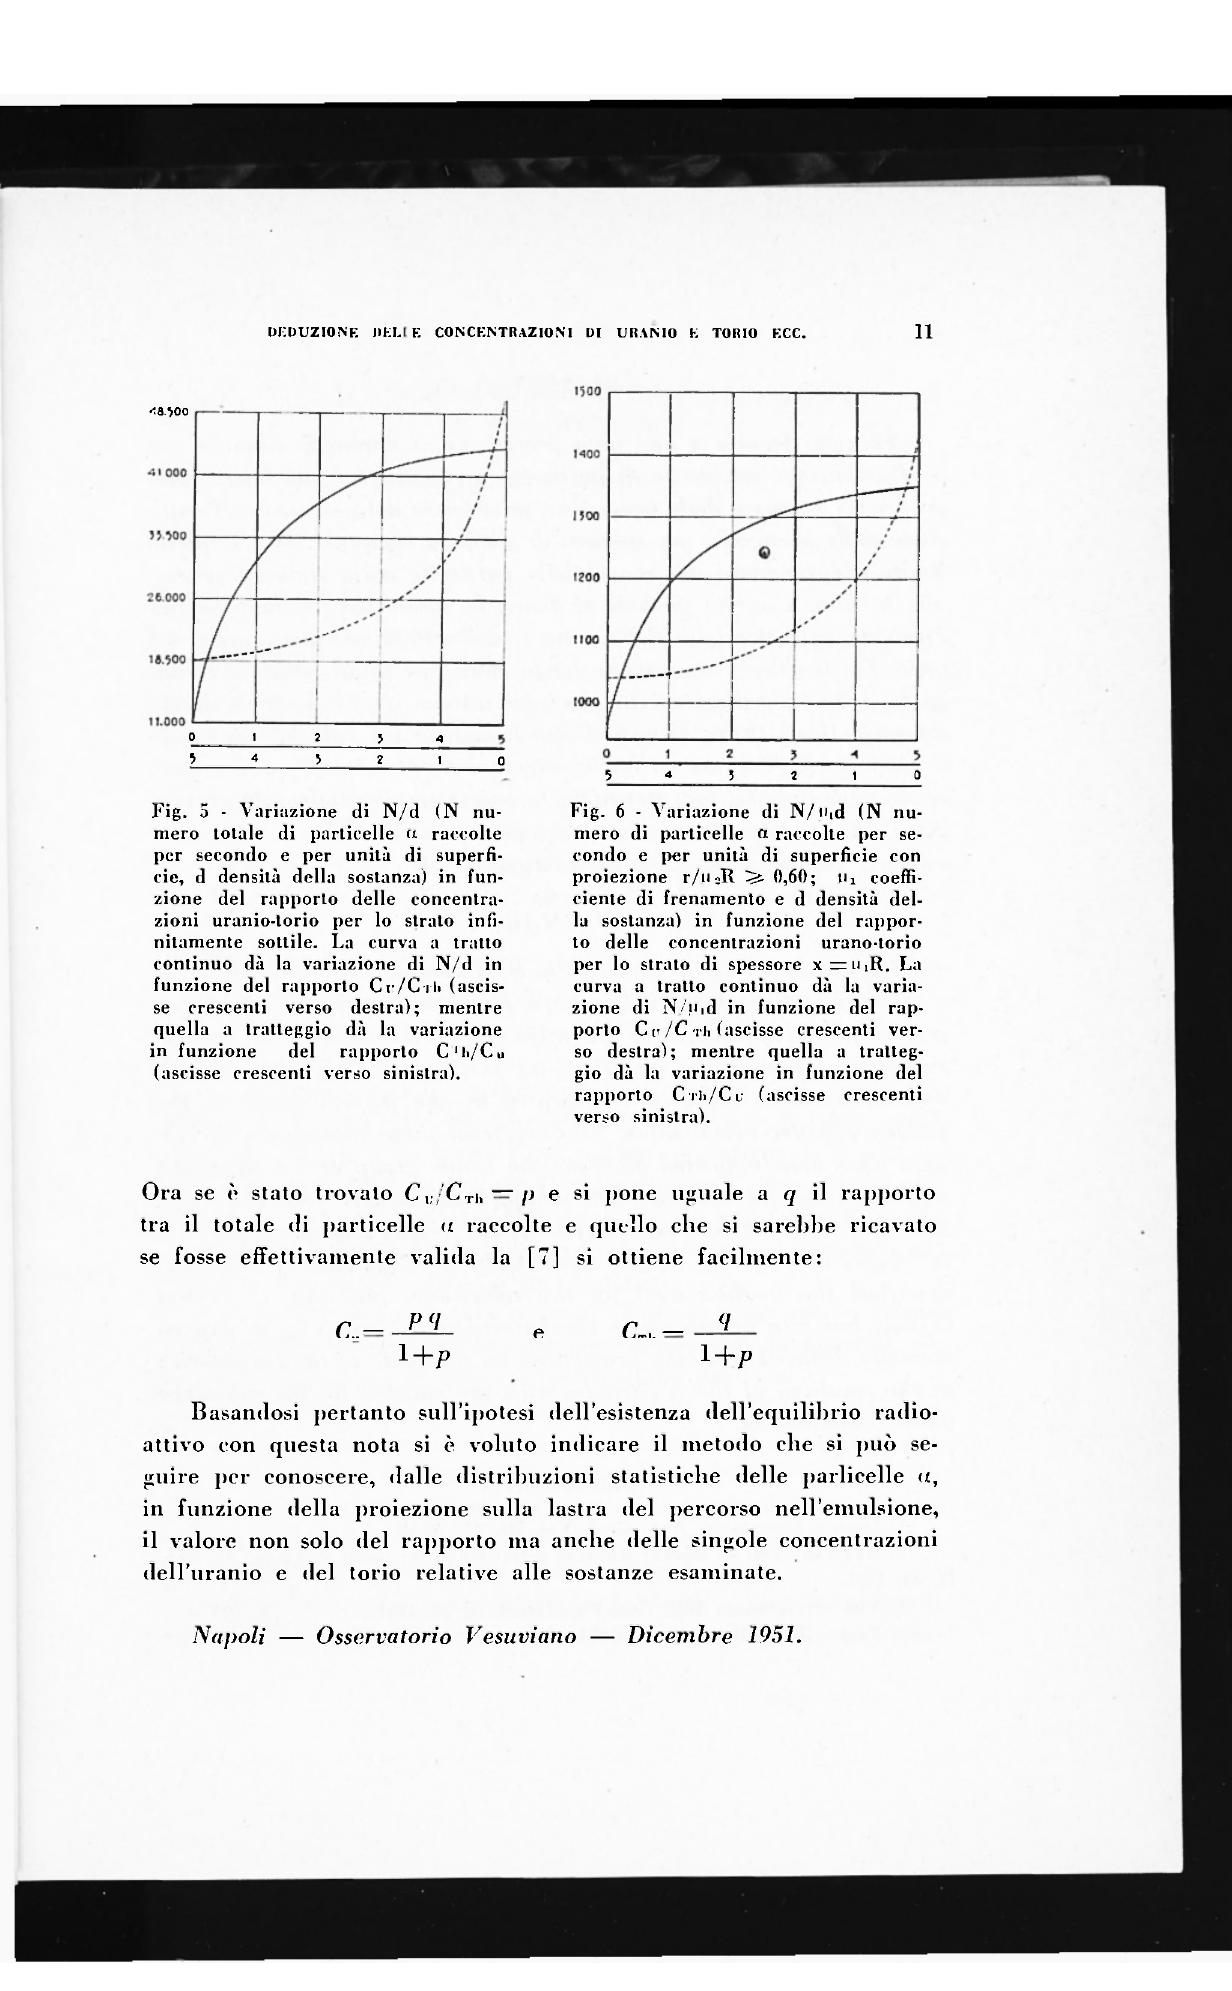
Fig. 6 - Variazione di N/ti,d (N nu- mero di particelle a raccolte per se- condo e per unità di superficie con proiezione r/u = R 5^0,60; tii coeffi- ciente di frenamento e d densità del- la sostanza) in funzione del rappor- to delle concentrazioni urano-torio per lo strato di spessore x = UiR. La curva a tratto continuo dà la varia- zione di N/Mid in funzione del rap- porto C TI /C TH (ascisse crescenti ver- so destra) ; mentre quella a tratteg- gio dà la variazione in funzione del rapporto CTII/CU (ascisse crescenti verso